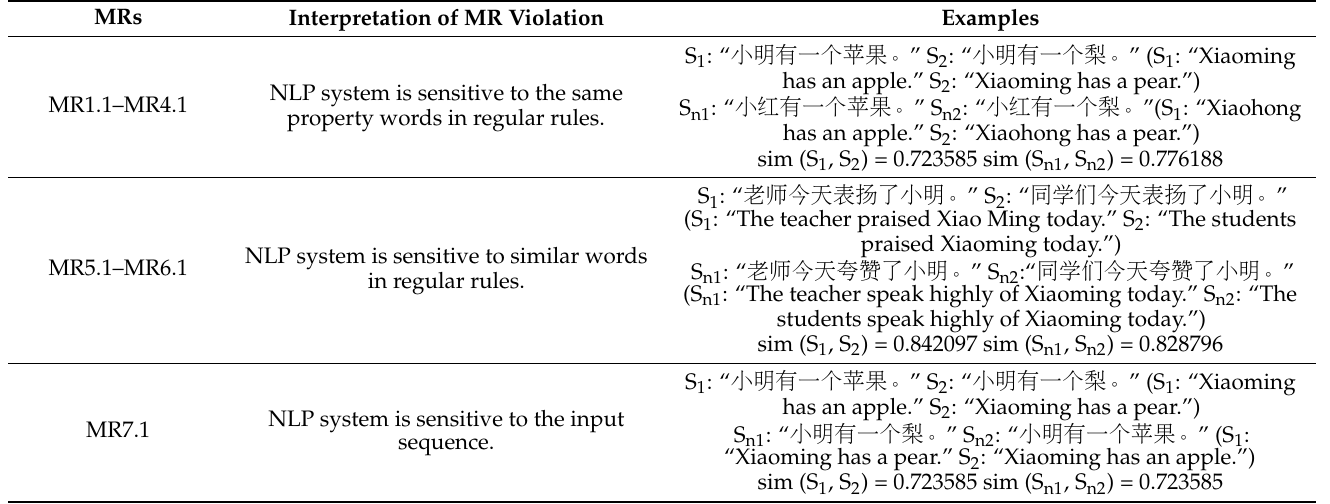
Table 2 further explains the above MR1.1–7.1: Table 2. Explanation and simple example of text similarity